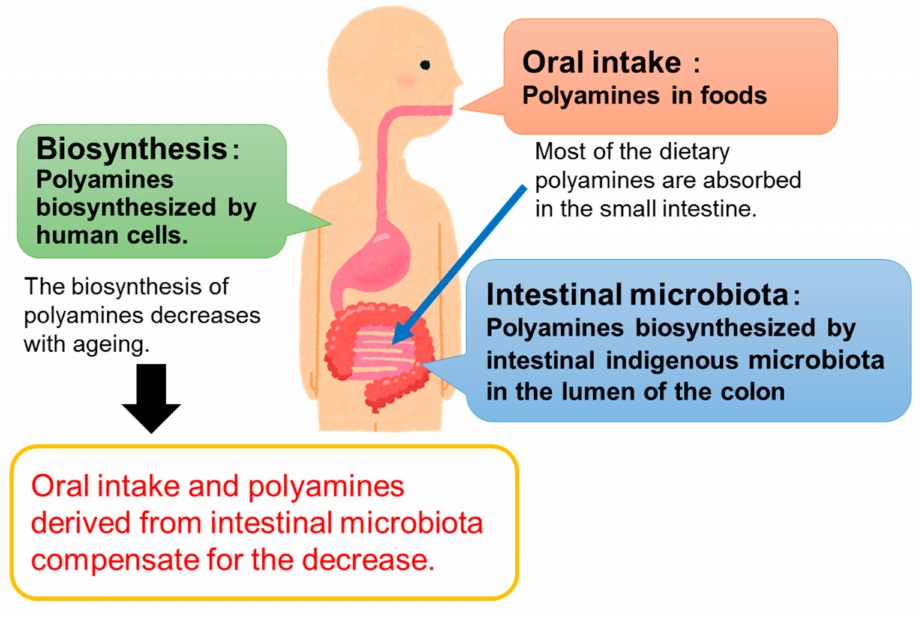
Figure 1. Sources of polyamines in